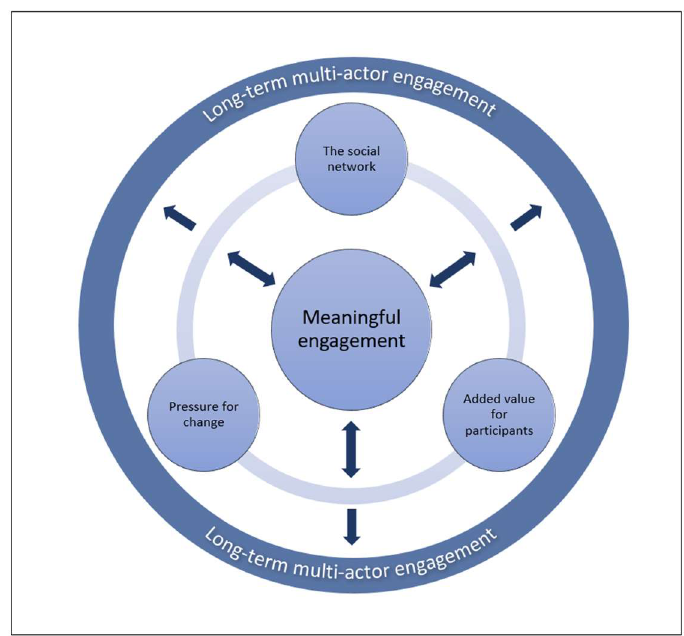
Figure 1. Key factors for long-term multi-actor engagement.